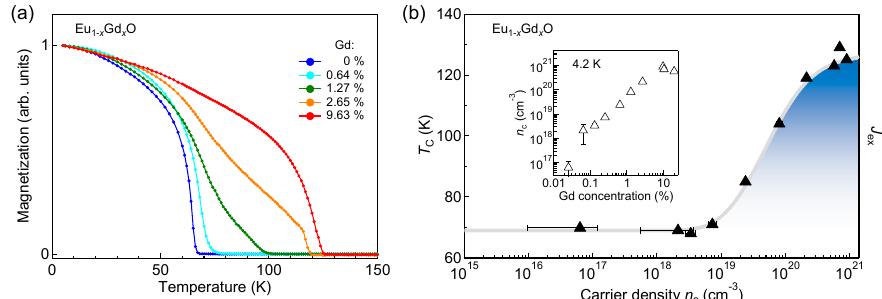
Figure 3. Changes in static magnetic properties of ferromagnetic semiconductor Eu 1 − x Gd x O films by carrier doping [31]. ( a ) Temperature dependence of the magnetization in Eu 1 − x Gd x O for some characteristic Gd concentrations. ( b ) Carrier density n c dependence of the Curie temperature T C . The inset shows the relation between Gd concentration and carrier density n c .